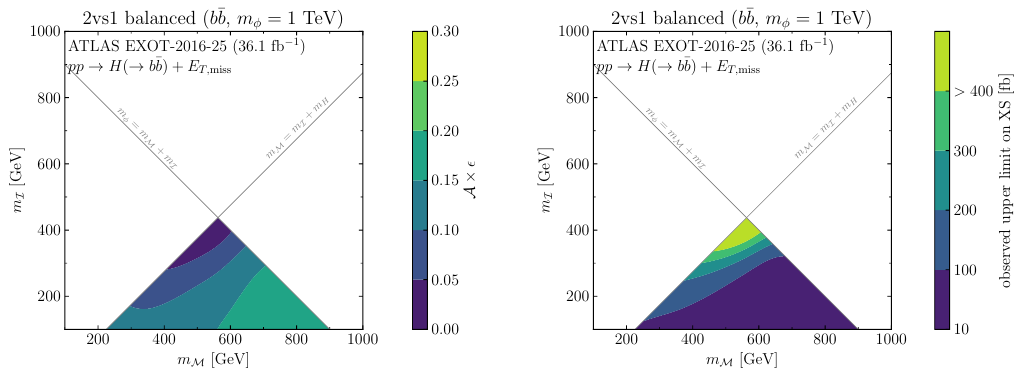
Figure 18. Acceptance × efficiency map (left) and observed upper limit on the cross section (right), derived by recasting the ATLAS mono-Higgs plus E miss of ref. [52], for the 2vs1 balanced